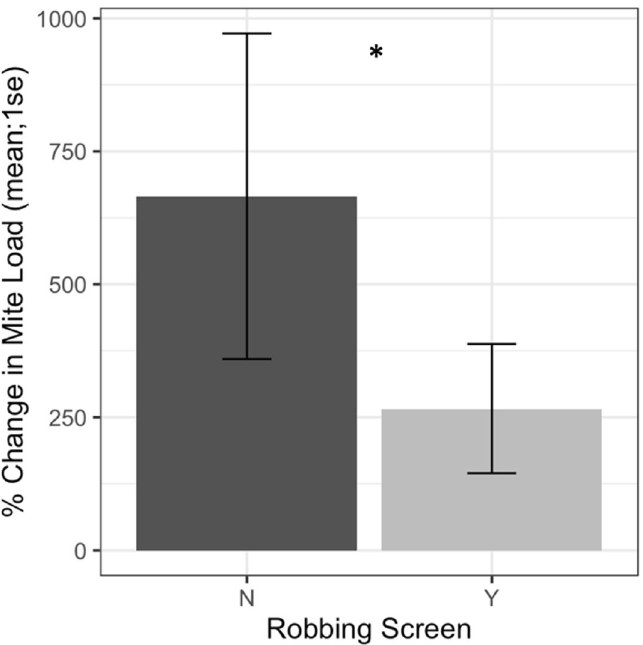
Figure 14. Percent change in Varroa loads in colonies with and without robbing screens. Colonies with robbing screens had reduced increases in Varroa population compared to unscreened colonies ( glm *p = 0.02).